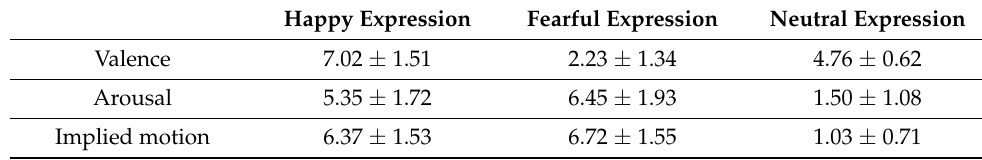
Table 1. Mean ± S.D. of arousal, valance and implied motion ratings of the